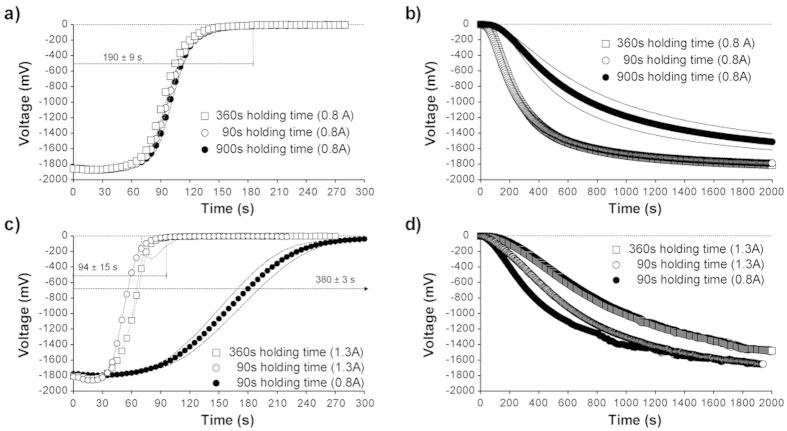
Response time and reforming time of H-tube depending on the applied current and the holding time.(a) Response time of H-tube 1 under 0.8 A current. (b) H-tube 1 reforming times (0.8 A). (c) Response time of H-tube 2 under 1.3 A current. (d) H-tube 2 reforming times (1.3 A). Shown data are averages and all dashed lines represent for the standard deviation (n = 3).